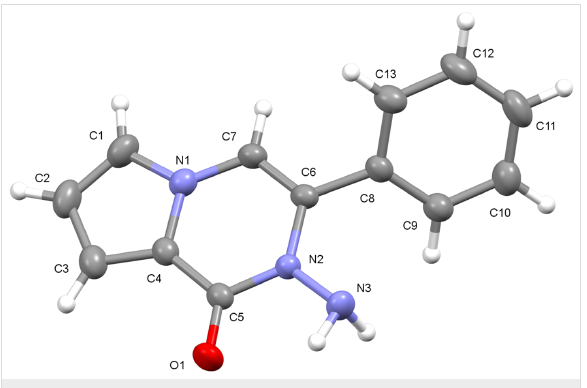
Figure 5: Single-crystal X-ray structure of 12c shown with 40% proba- bility displacement ellipsoids.